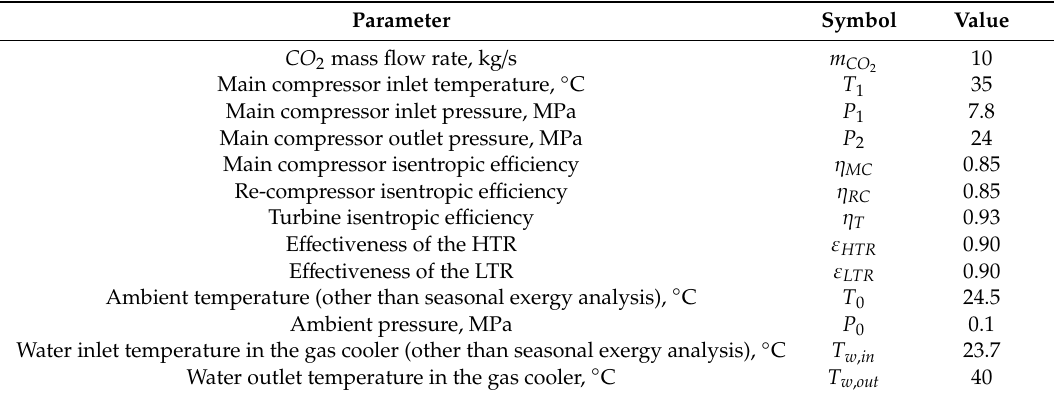
Figure 2. Ambient and water temperature data for the city of Busan [19]. Table 1. Design parameters used in sCO 2 cycle